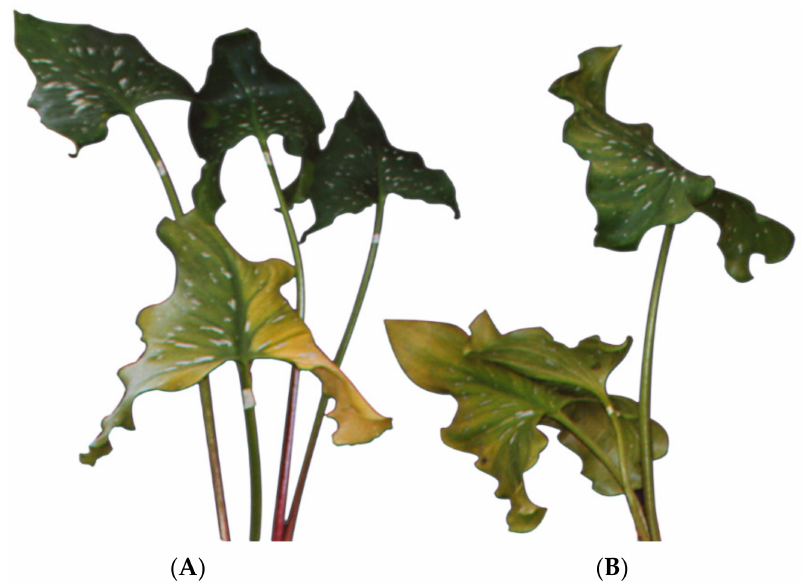
Figure 1. Leaves of Zantedeschia elliottiana ‘Black Magic’. ( A ) control ( B ) conditioned in GA 3 at a concentration of 300 mg dm − 3 and stored in 8HQC.